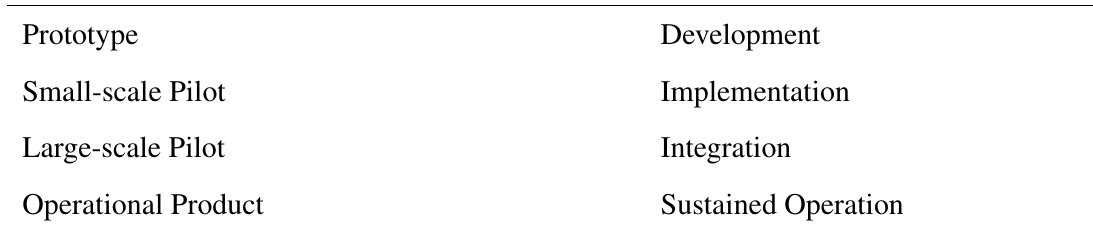
Table 5. Typical lifecycle stages for telehealth